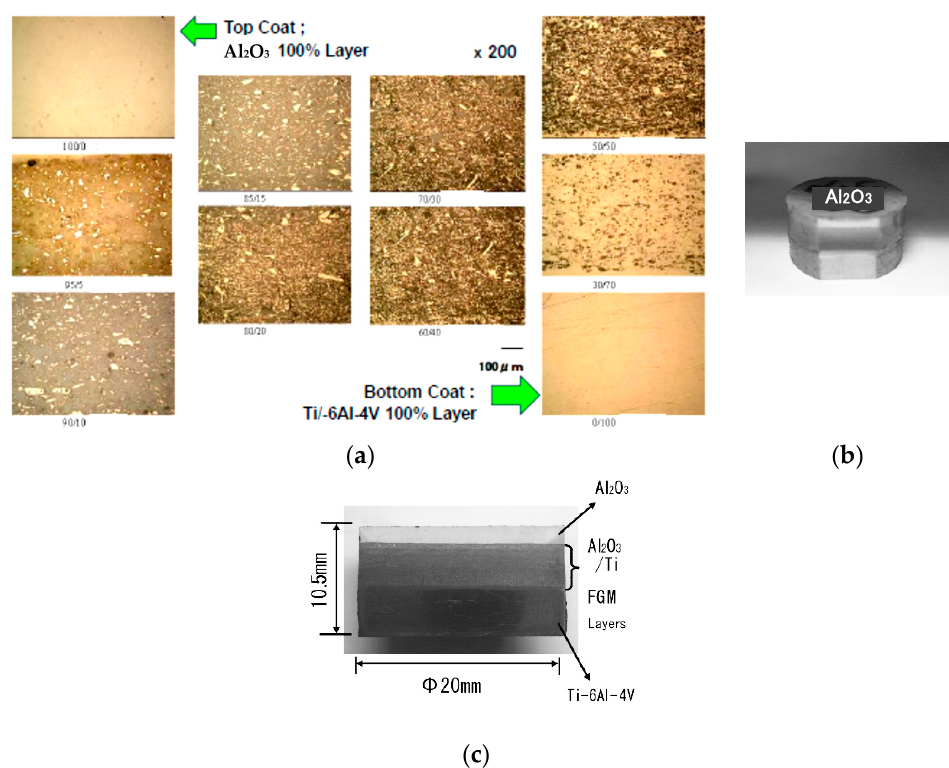
Figure 39. ( a ) Optical micrographs of 10 layered SPSed specimen of Al 2 O 3 /Ti/Ti-6Al-4V system FGMs; ( b ) Outside view of partially grinded SPSed FGMs specimen (the 1st upper layer: 100% dense Al 2 O 3 layer); ( c ) Cross section of Al 2 O 3 /Ti/Ti-6Al-4V system FGMs.